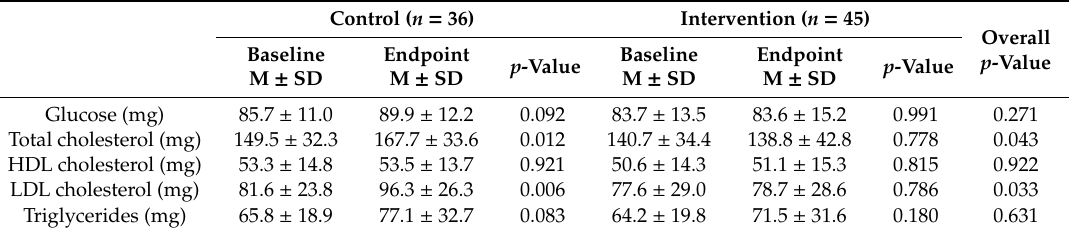
Table 5. Biochemical measurements of the study population. Control ( n = 36) Intervention ( n = 45)